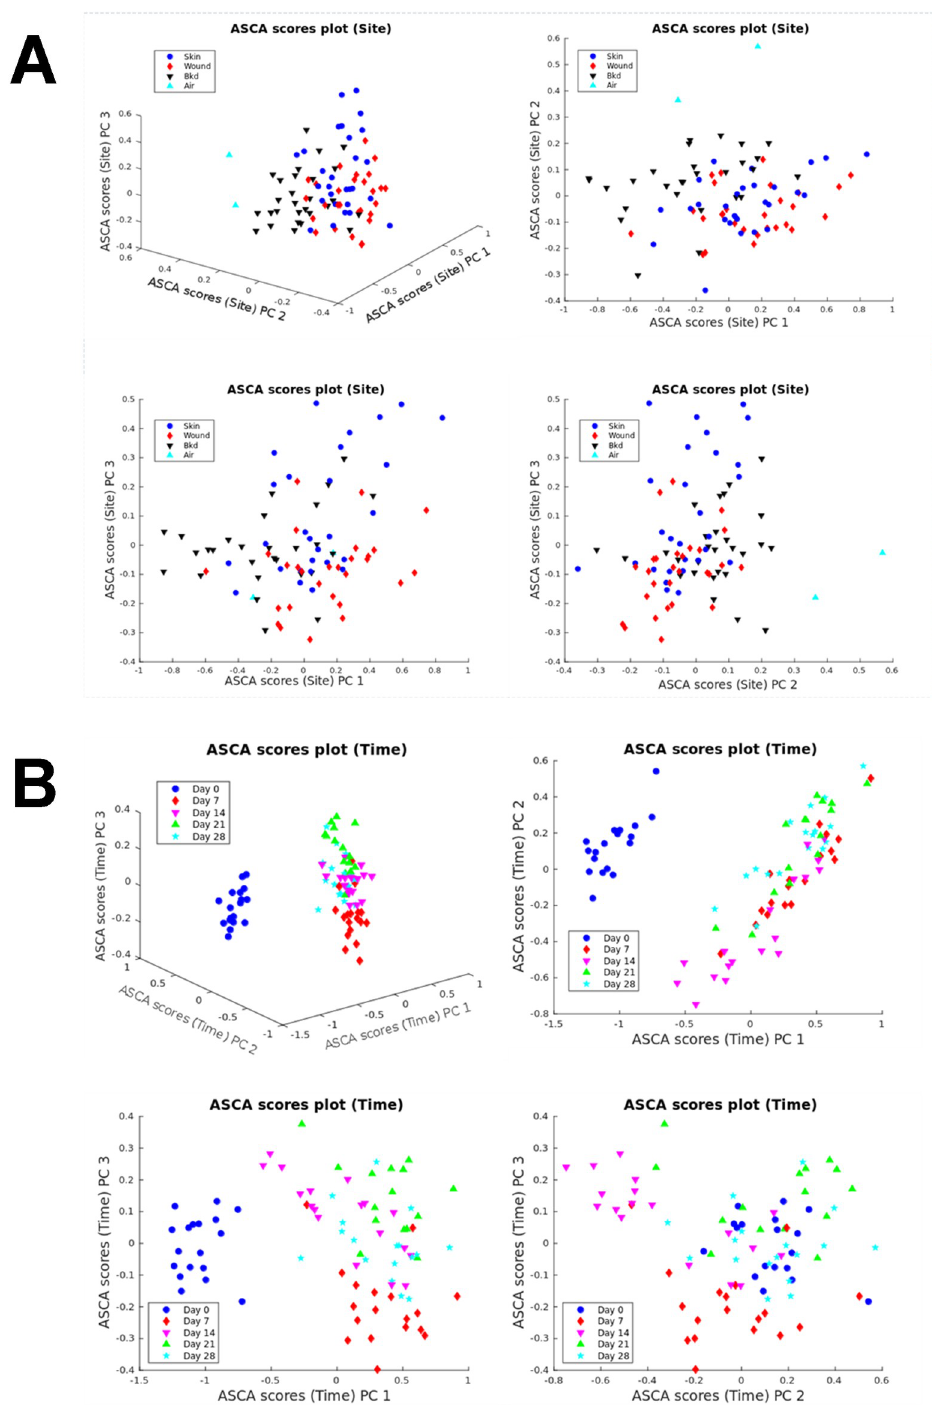
Fig 3. Analysis of variance–simultaneous component analysis (ASCA) on wound headspace metabolome. (A) ASCA scores plot for site. (B) ASCA scores plot for time. time points on the PC1 axis with a TEV of 27.84%. The greatest separation was seen between day 0 and 7 and there was a gradual return towards day 0 parameters from day 7 to day 28.